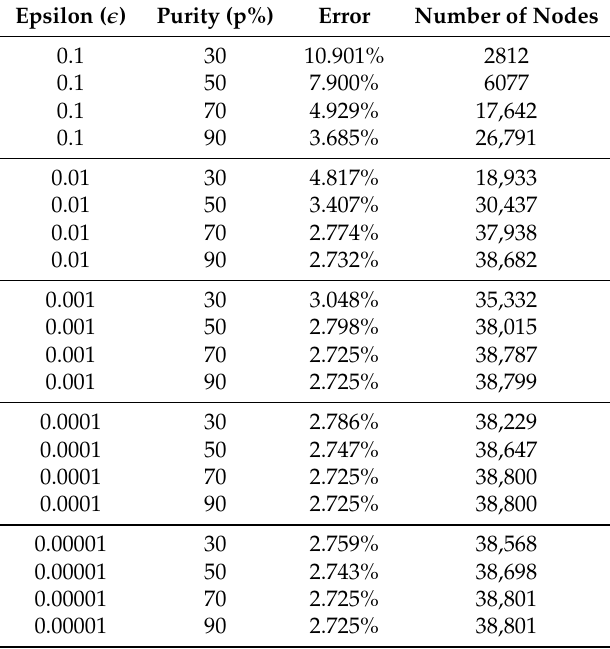
Table 3. The results of the errors and number of found nodes using different values for (cid:101) and purity. The dimension of the blocks was